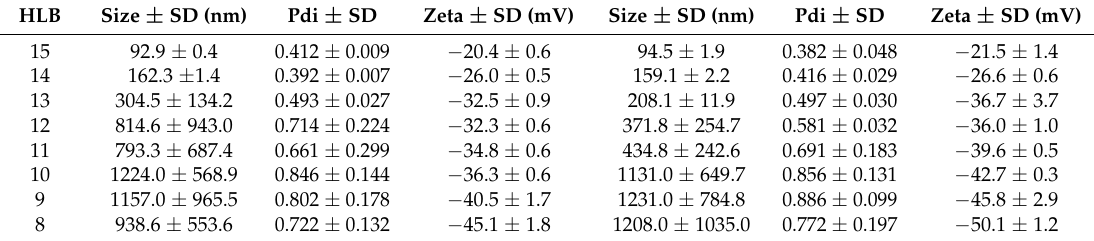
Table 2. Physicochemical characterization of nanoemulsions containing B. reticularia essential oil.